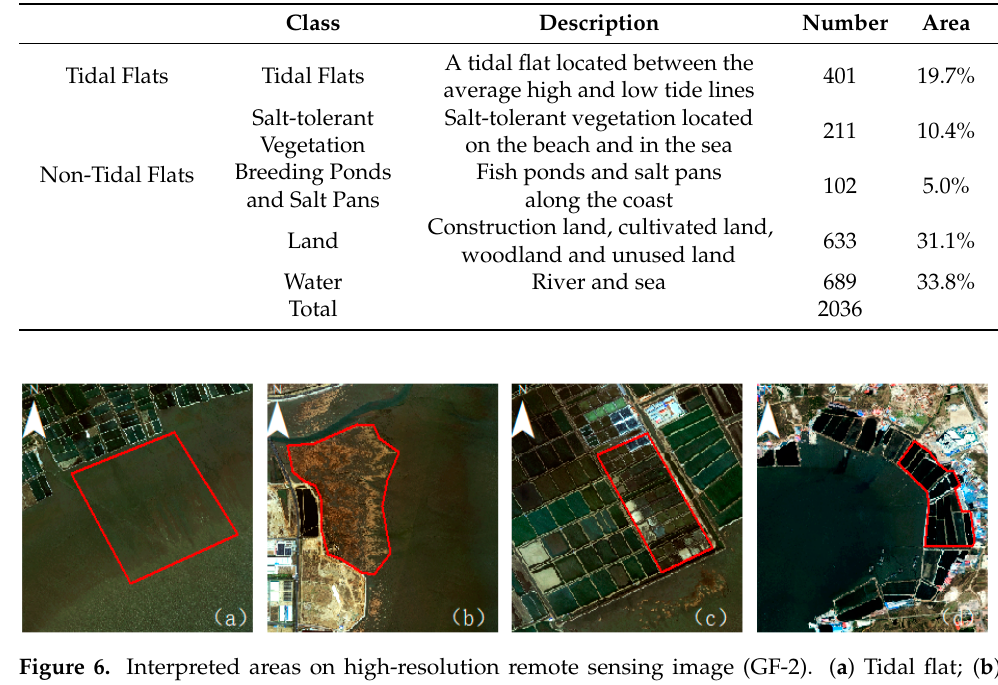
Table 2. Land cover types and their corresponding sample numbers.